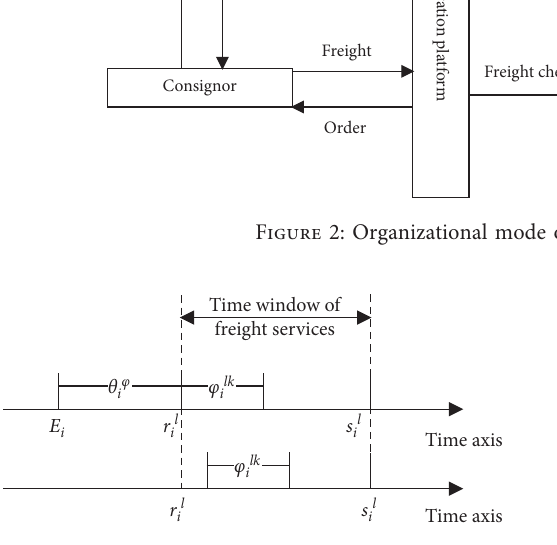
Figure 3: Time window for freight